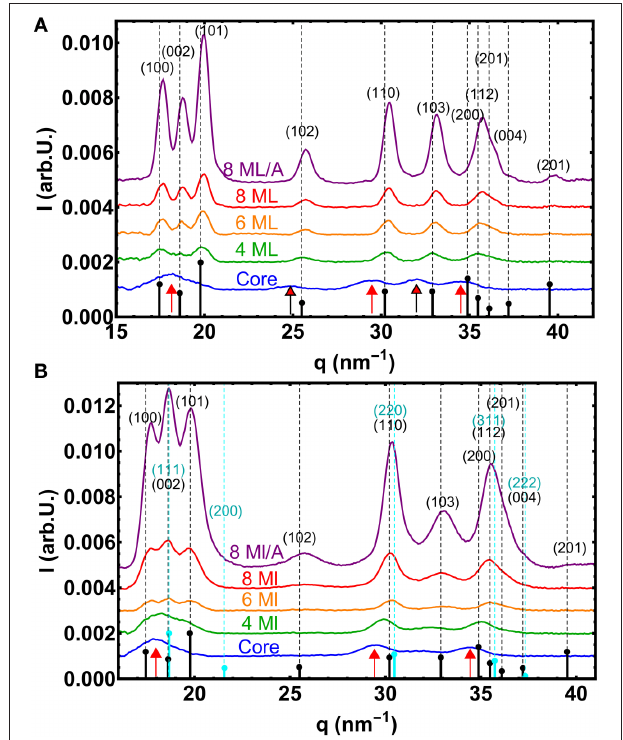
FIGURE 4 | (A) WAXS curves of the small core/shell NC series. The vertical dashed lines mark the theoretical positions of the Bragg peaks for unstrained bulk CdS in the hexagonal wurtzite phase. The theoretical relative intensities are symbolized by small black sticks, whereas the red arrows mark the theoretical positions for wurtzite CdSe. (B) The same for the large core/shell NC series, but now also with the marked positions and intensities the for cubic zincblende CdS phase (cyan). Here the red arrows mark the positions of cubic zincblende